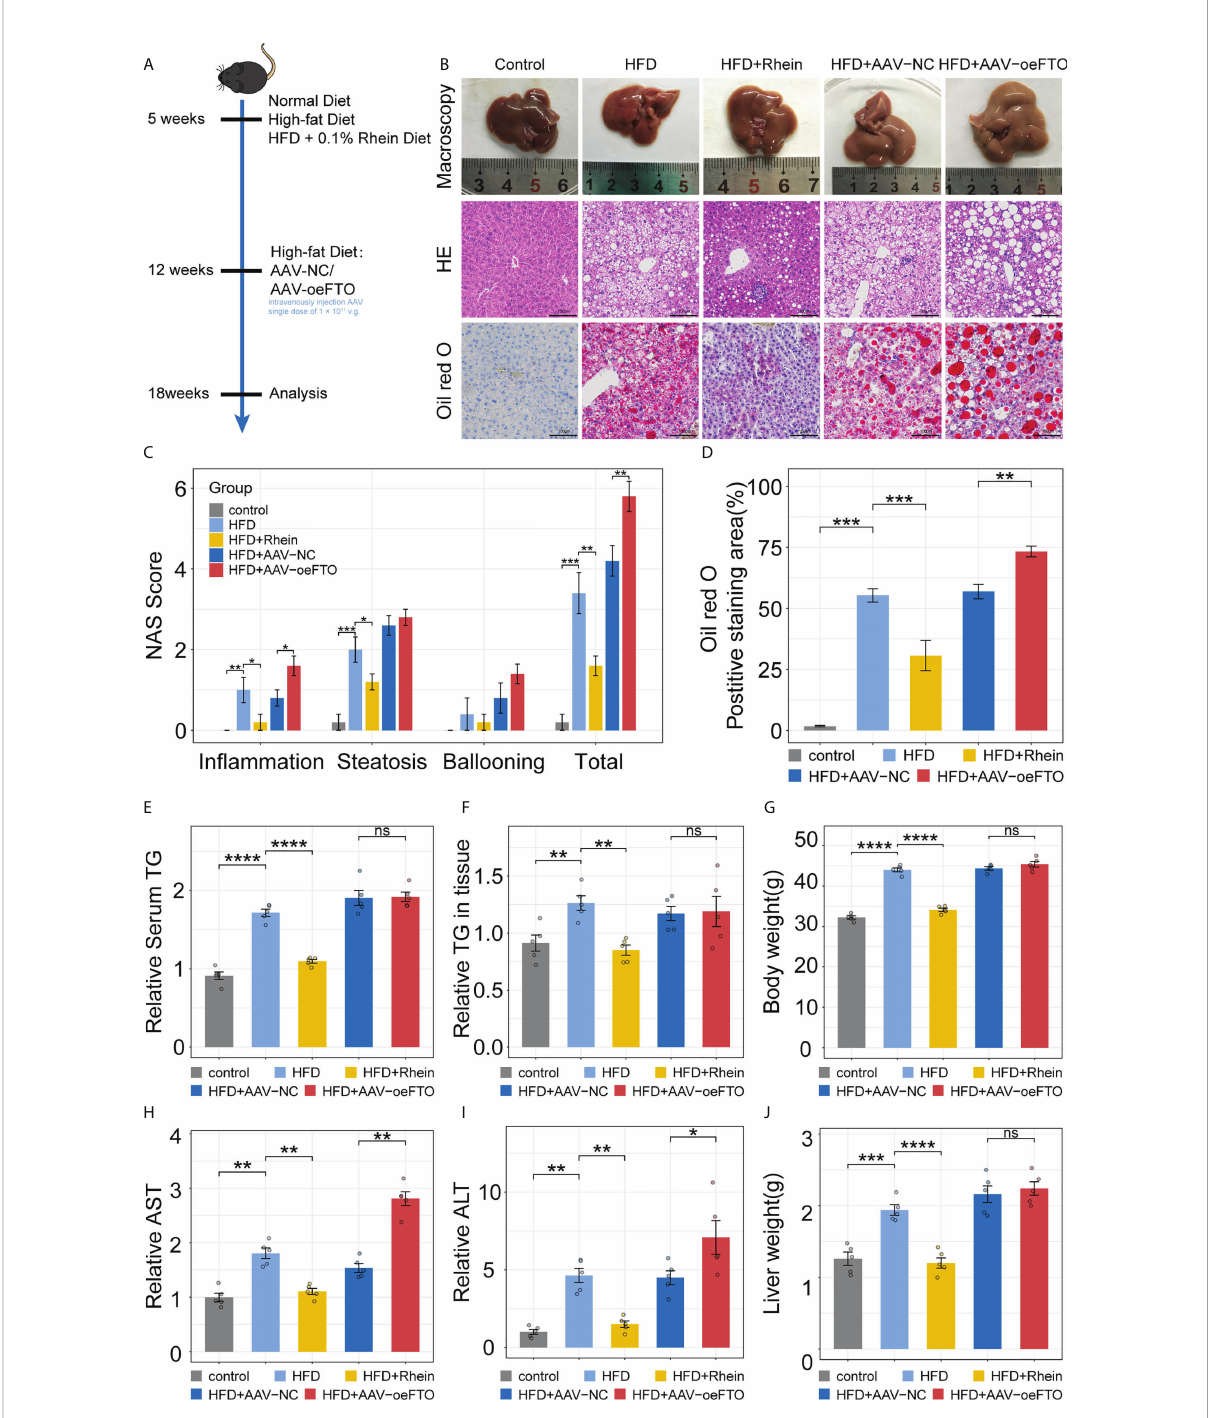
FIGURE 4 FTO promotes liver damage in murine NAFLD model. (A) Schematic of the in vivo experimental setup for construction of murine NAFLD model to ascertain FTO function. (B) Representative images of liver tissues in groups with different treatment by macroscopy and light microscopy (H&E staining and Oil red O staining). (C) NAFLD Activity Score (NAS), including in fl ammation, steatosis, ballooning, and total NAS in all groups with different treatment. (D) Quantitative analysis of Oil red O intensity in all groups with different treatment. (E) Relative serum TG in all groups with different treatment. (F) Relative TG level in liver tissues of all groups with different treatment. (G) Body weight of mice in all groups with different treatment. (H, I) . Relative serum AST, and ALT in all groups with different treatment. (J) Liver weight of mice in all groups with different treatment. All experiments were repeated at least three times and expressed as the means ± SEM. n = 5; ns, not signi fi cant; * p < 0.05; ** p < 0.01; *** p < 0.001; **** p <